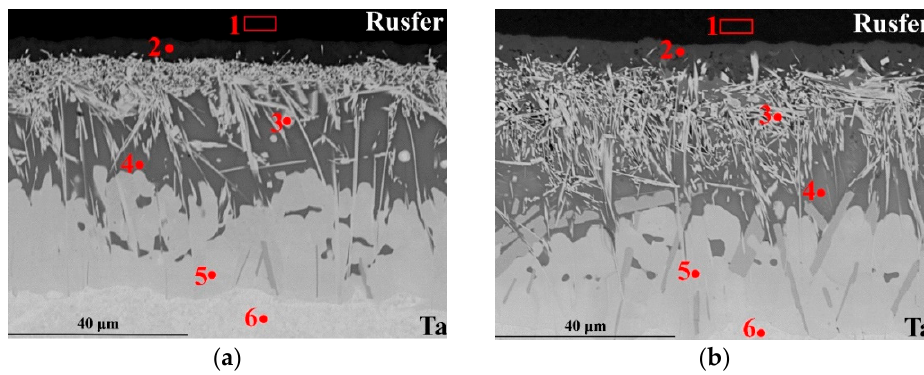
Figure 15. Quantitative SEM analysis represented in Table 1 of Rusfer/TiZr4Be/Ta seam in: ( a )—as-joined (0) and ( b )— thermo-cycled (200).